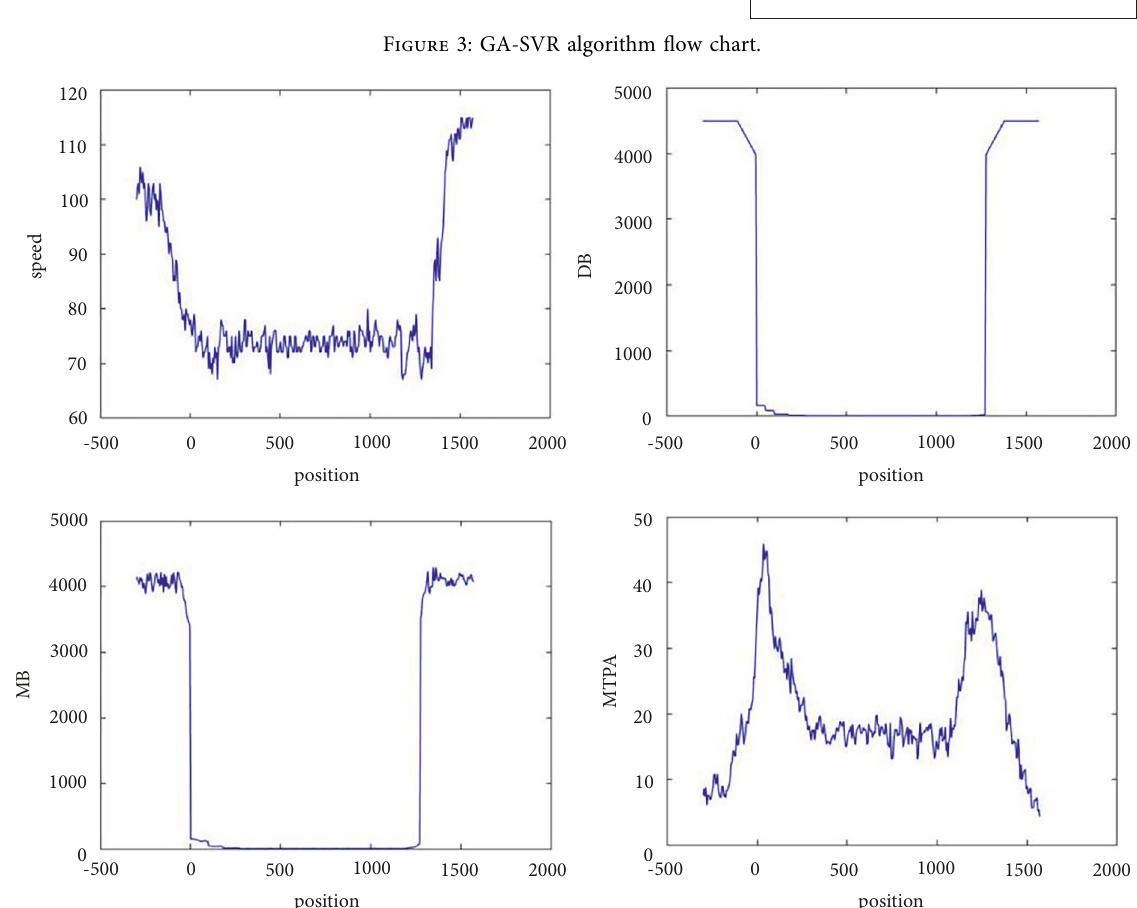
Figure 4: The relationship between speed, design brightness, measured brightness, MTPA, and position.